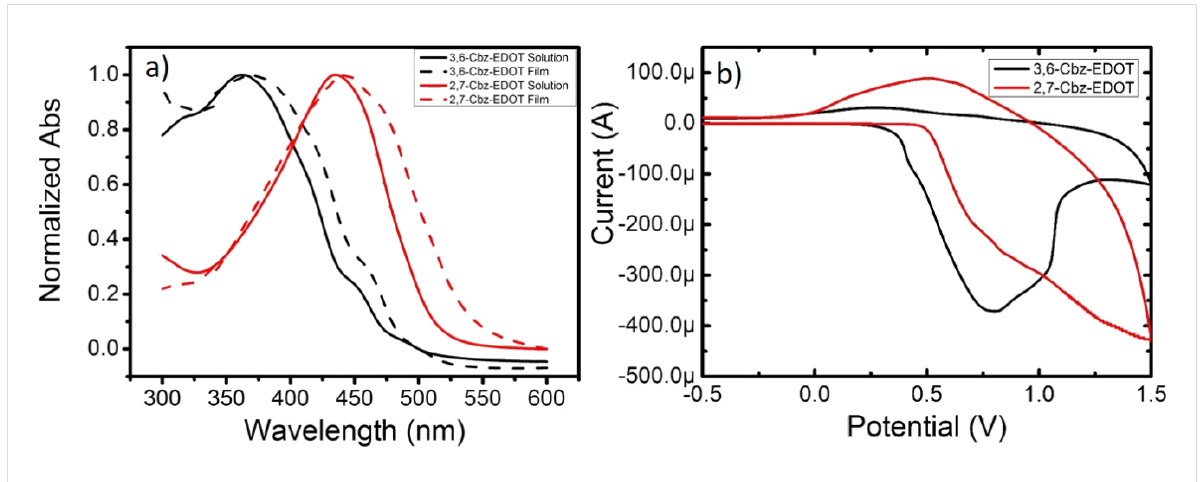
Figure 1: (a) Normalized UV–vis absorption of Cbz-EDOT polymers in CH 2 Cl 2 measured at 10 − 5 M repeat unit − 1 and in thin films and (b) cyclic vol- tammetry of Cbz-EDOT polymer films on glassy carbon electrode, measured in CH 3 CN with 0.1 M ( n -C 4 H 9 ) 4 NPF 6 at the scan rate of 0.1 V s − 1 under flowing